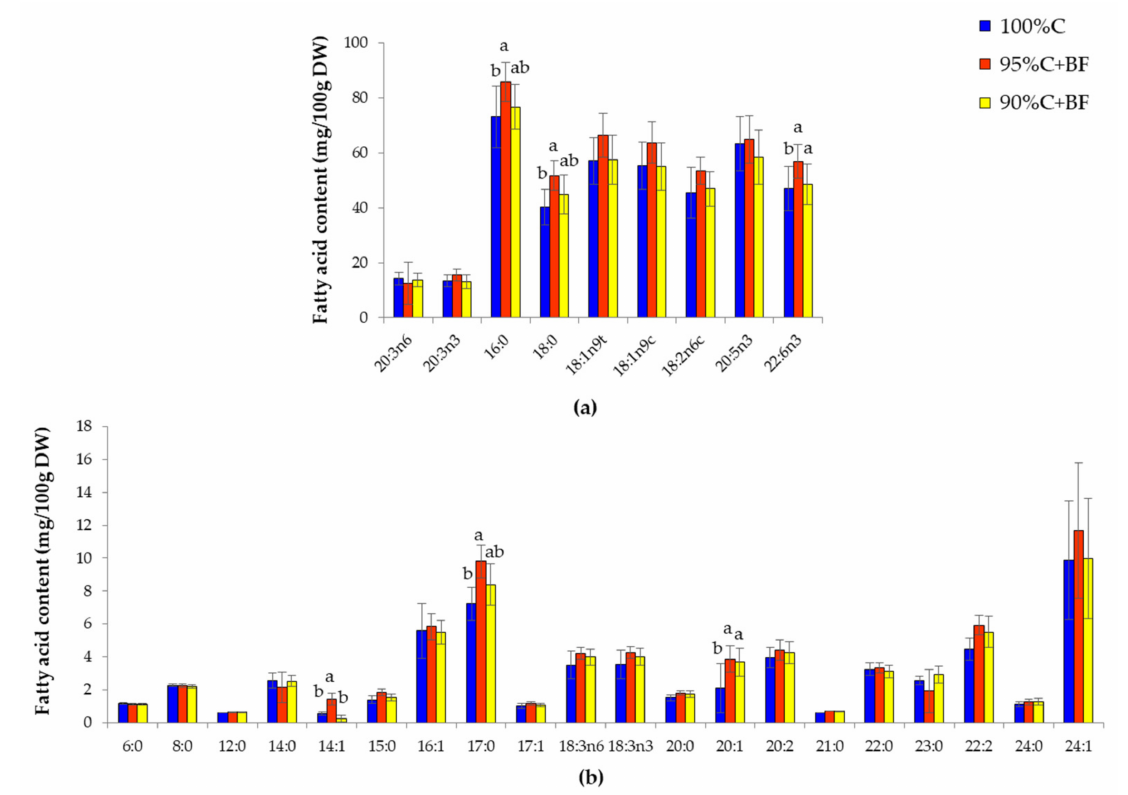
Figure 5. Fatty acid profiles analysis of shrimp-fed with commercial pellet (100%C, blue) and shrimp-supplemented with ex-situ biofloc in different commercial pellet reduction ratios (95%C+BF, red; 90%C+BF, yellow). Error bars represent a value of ± standard derivation. Different letters above bars (a and b) represent a significant difference among the three